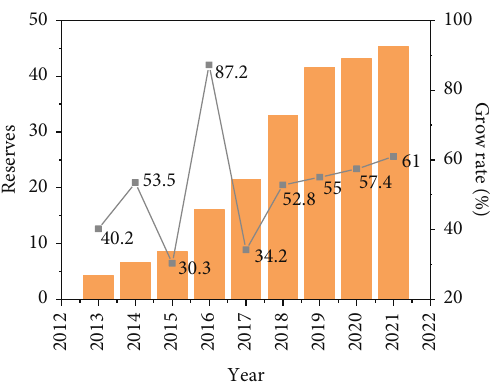
Figure 2: Global big data reserves and growth rate from 2013 to 2021.